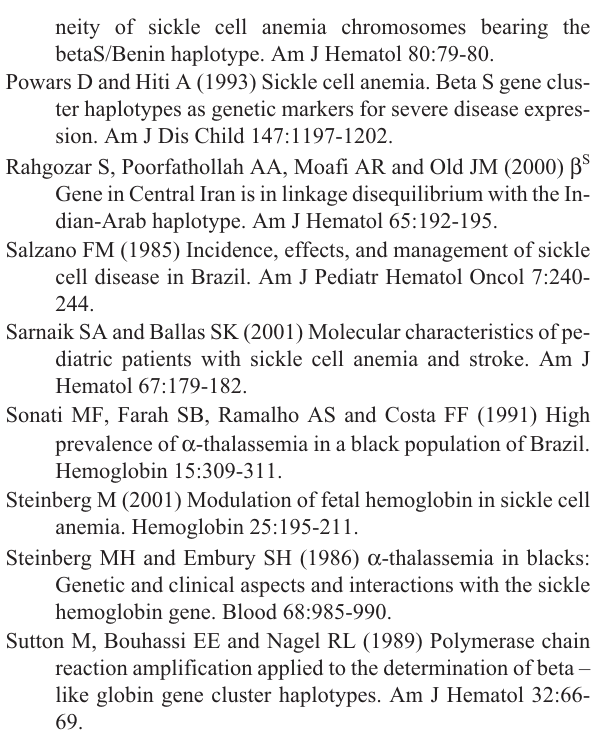
- Table S1. Hematological and clinical characteristics of sickle cell anemia outpatients from Bahia (Brazil) who were ≤ 18 y and had fetal hemoglobin (HbF) levels = 10.0 and > 10.0%. - Table S2. Hematological and clinical characteristics of sickle cell anemia outpatients from Bahia (Brazil) who were > 18 y and had fetal hemoglobin (HbF) levels = 10.0 and > 10.0%. - Table S3. Age and phenotypic characteristics of sickle cell anemia outpatients from Bahia (Brazil) with dif- ferent beta S-globin gene ( β S -globin) haplotypes. - Table S4. Gender, hematological and phenotypic characteristics of sickle cell anemia outpatients from Bahia (Brazil) with different alpha-thalassemia 2 gene 3.7 kb de- letion (- α 23.7 kb )